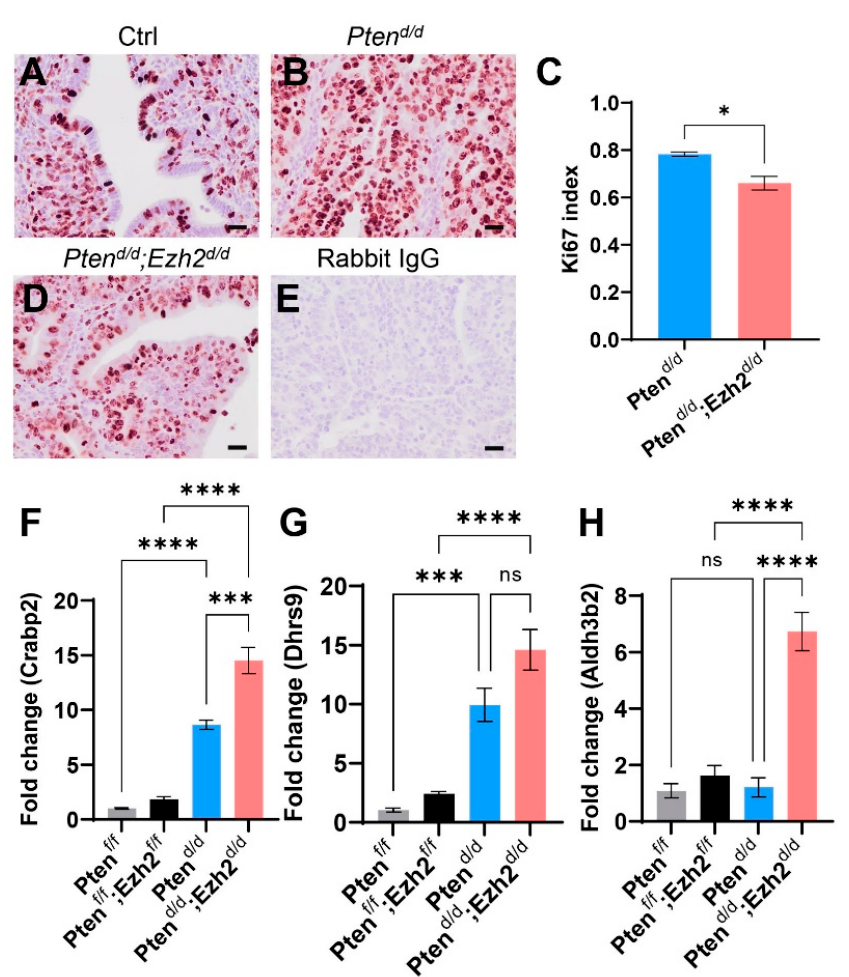
Figure 2. Reduced Ki67 index in the uteri of Pten d/d ; Ezh2 d/d mice compared with Pten d/d mice. ( A – E ) Immunohistochemical analysis of Ki67 using three-week-old Pten f/f (Ctrl), Pten d/d , and Pten d/d ; Ezh2 d/d mice. Ki67 index for Pten d/d and Pten d/d ; Ezh2 d/d mice is shown in panel ( C ). n = 3. Data are mean ± s.e.m. * p < 0.05. Scale bar = 20 µm ( A , B , D , E ). ( F – H ) Transcript levels of Crabp2 , Dhrs9 , and Aldh3b2 in uterine tissues from Pten f/f , Pten f/f ; Ezh2 f/f , Pten d/d , and Pten d/d ; Ezh2 d/d mice at three weeks of age. n = 4. Data are mean ± s.e.m. *** p < 0.001 and **** p < 0.0001. ns, not significant. 3.3. Ezh2 and Pten Deletion Enhances the Accumulation of Intraluminal Neutrophils Compared with Pten Deletion